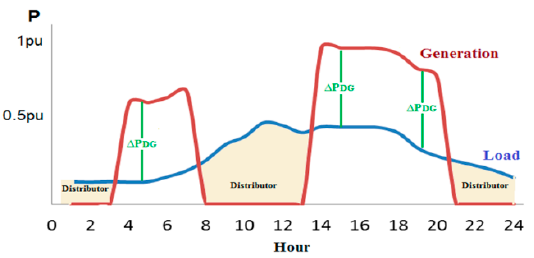
Figure 4. MOR Model 1 with two operating intervals for the biogas DG and availability to distributor.